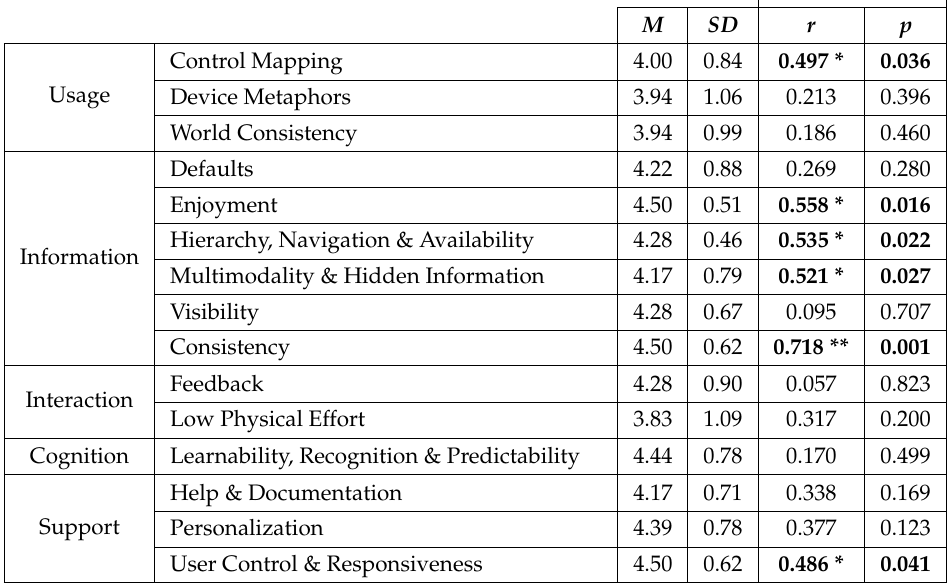
Table 2. Correlation results regarding pattern implementation and